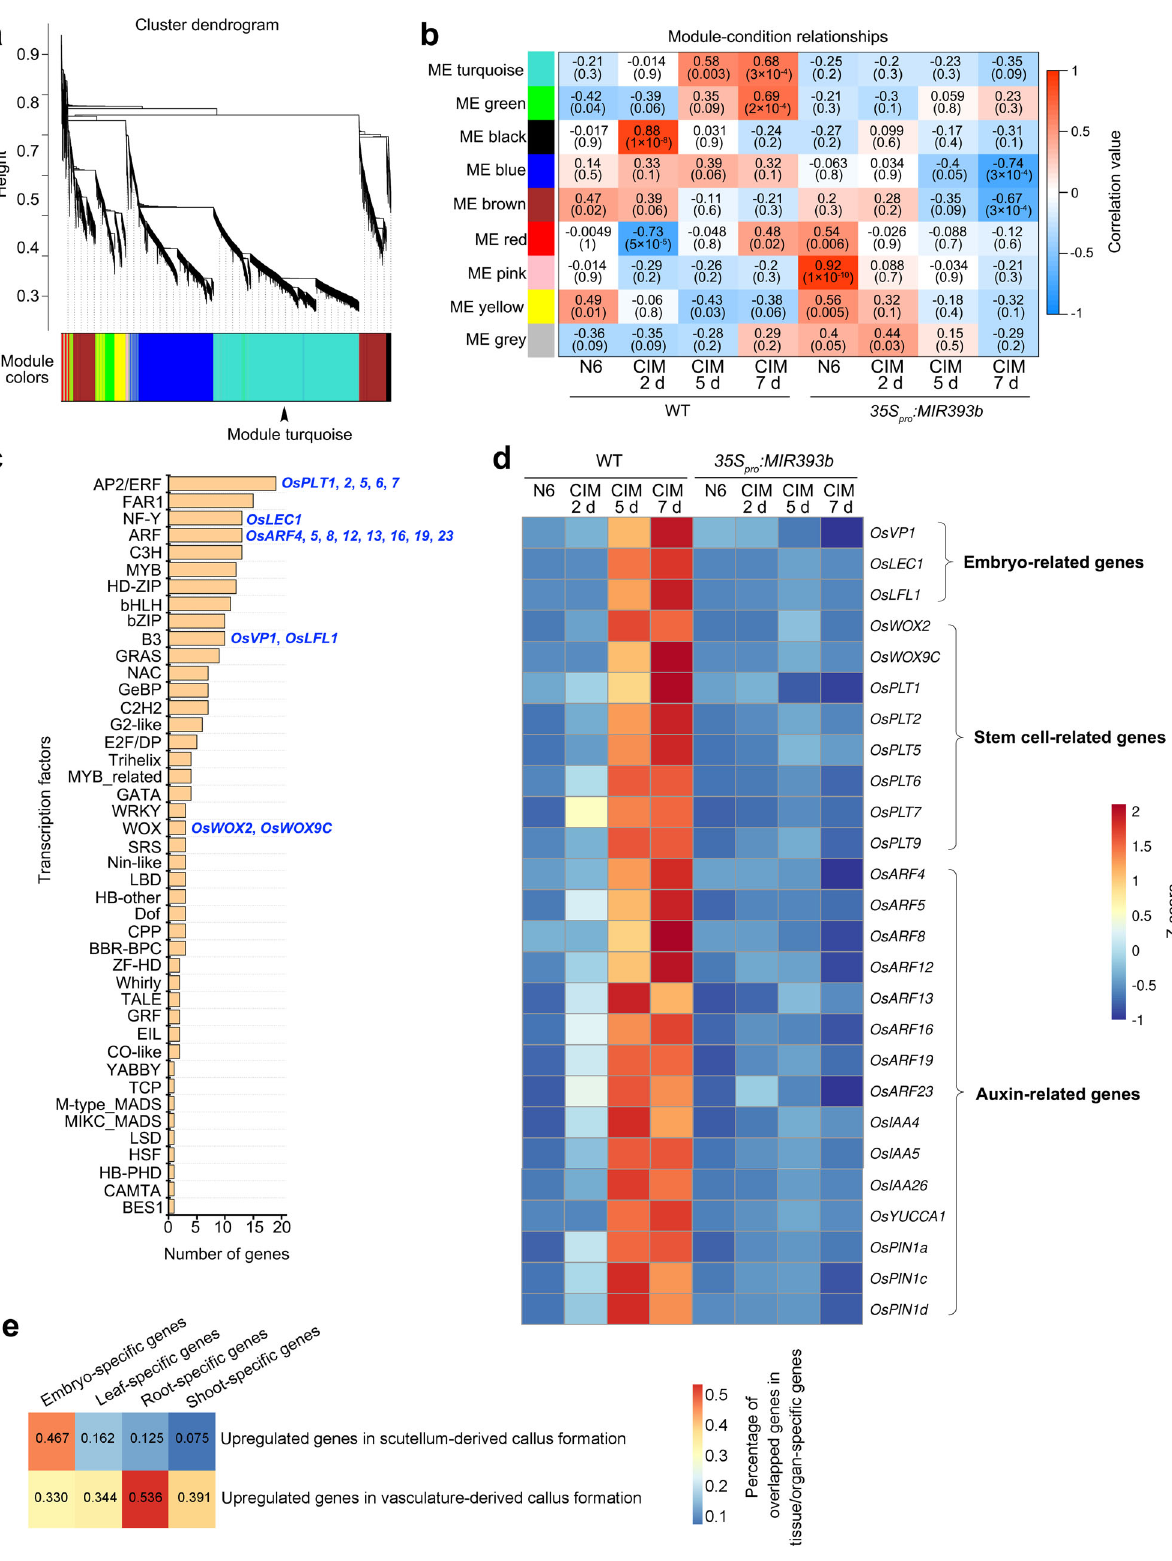
vasculature-derived callus initiation, while epidermis of embryo could be the primary source to initiate scutellum-derived callus. Second, the two types of calli show different developmental morphologies. The tissue structure of vasculature-derived callus resembles RP/RAM 6,10,11 and comprises three cell layers, i.e. the outer cell layer similar to epidermis and lateral root cap, the